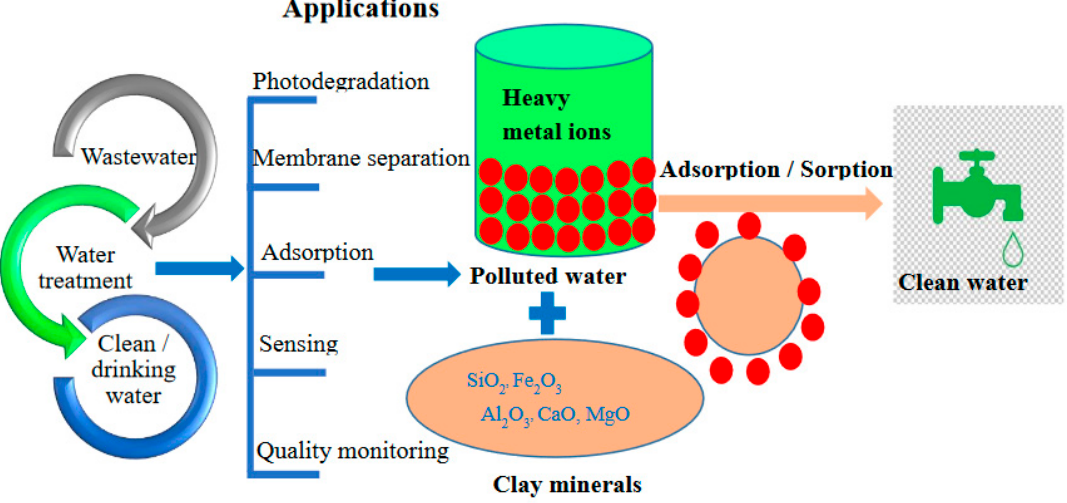
Figure 14. Role of nanocomposite in water purification and the removal of various heavy metal ions.